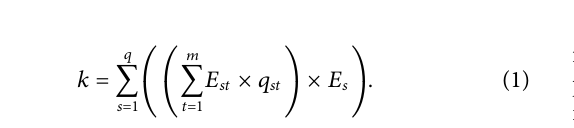
FIGURE 1 | Investment allocation indicator system for distribution network